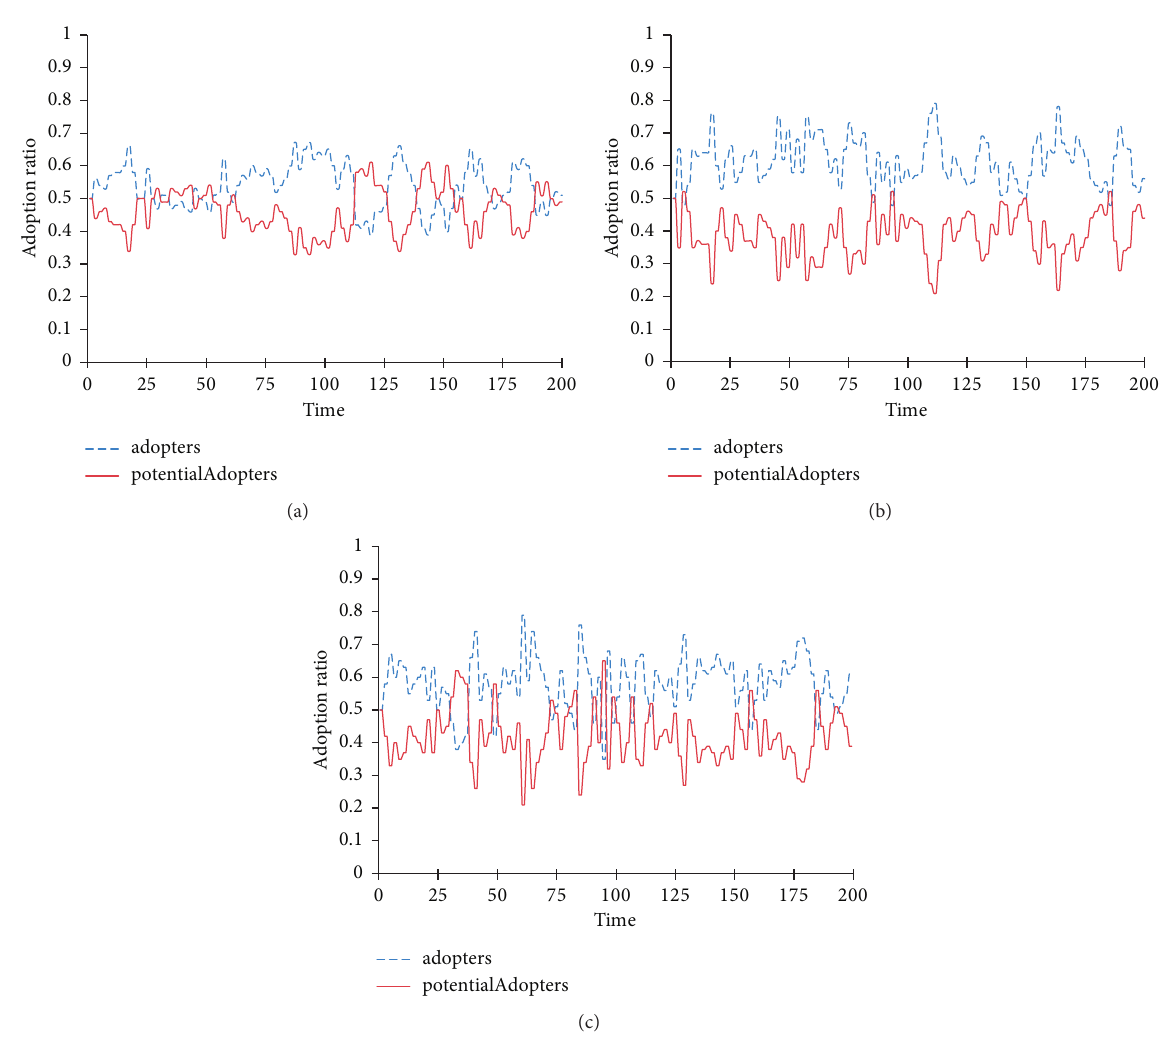
Figure 14: Effect of l on product diffusion. (a) l � 1, (b) l � 3, and (c) l �